Question: What type of chart is this?
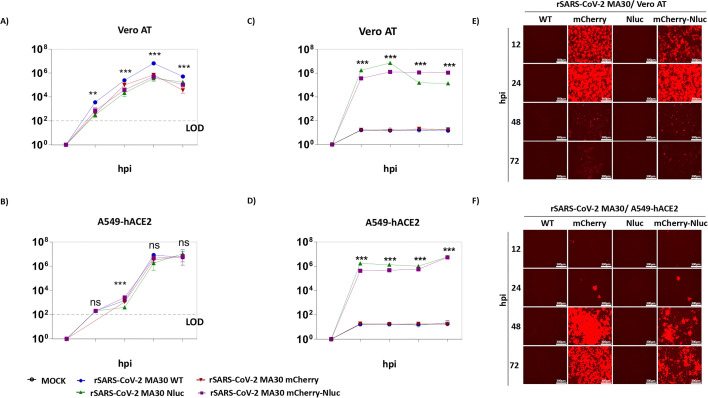
Answer: bar